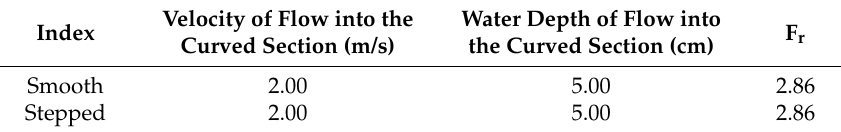
Table 5. The conditions of flow into the curved